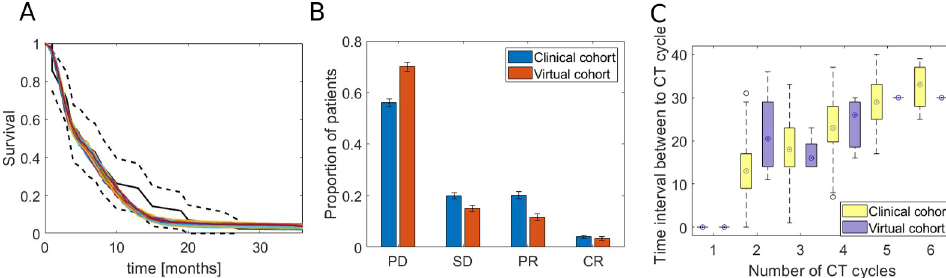
Fig 3. Calibration of the model to clinical data from NSCLC patients. A) Kaplan-Meier survival plot shows agreement between the virtual and clinical cohort. The black line shows the survival estimates for clinical data (solid line is an estimate, dotted lines define the 95% confidence interval). All other solid lines show Kaplan-Meier estimates for the virtual cohort (in total 100 cohorts with 1,000 patients each are shown). B) The plot shows agreement of the virtual cohort with a clinical one in terms of initial response. On the x-axis there is the initial response of patients by treatment effect: PD (progressive disease), SD (stable disease), PR (partial response) and CR (complete response) and on the y-axis there is proportion of patients in a cohort belonging to one of the four initial response class. C) The boxplot shows the relationship between the number of chemotherapy cycles (x-axis), and the time between the two consecutive chemotherapy cycles (y-axis).